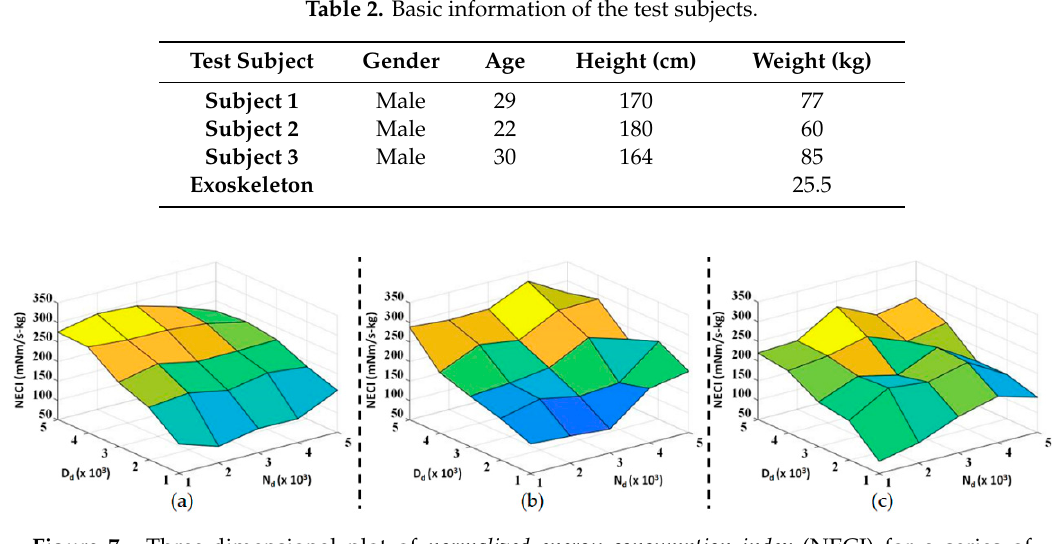
Figure 7. Three-dimensional plot of normalized energy consumption index (NECI) for a series of experiments as N d and D d vary from 1000 to 5000: ( a ) Subject 1; ( b ) Subject 2; and ( c ) Subject 3.